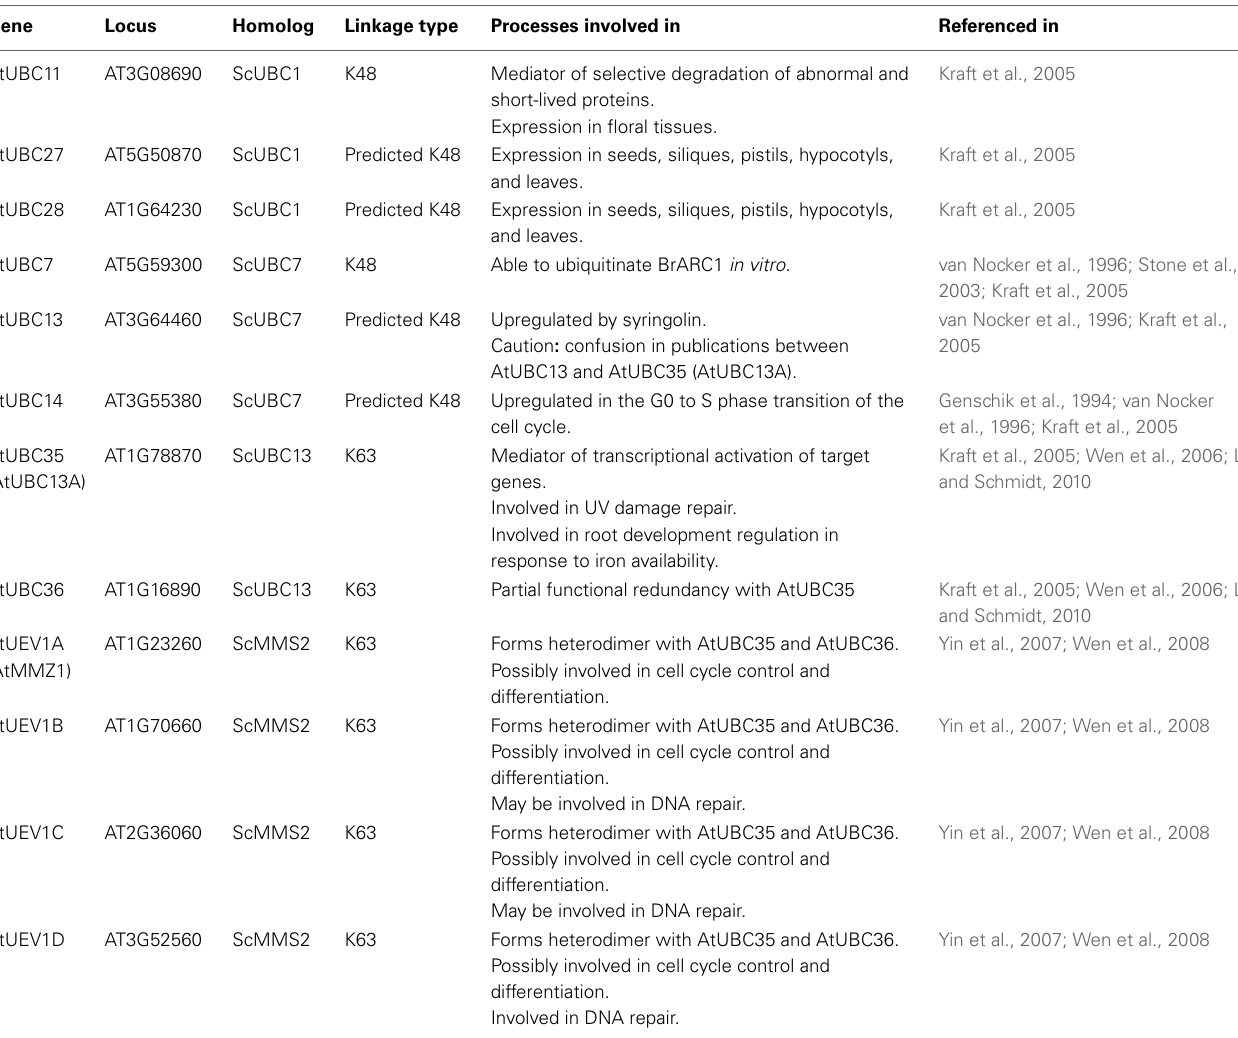
Table 1 | Arabidopsis E2 function.